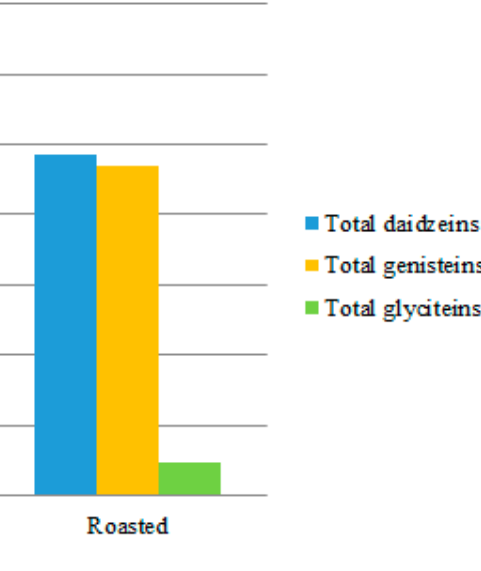
Figure 6. Comparison of three isoflavone types in RWSF and RSF.